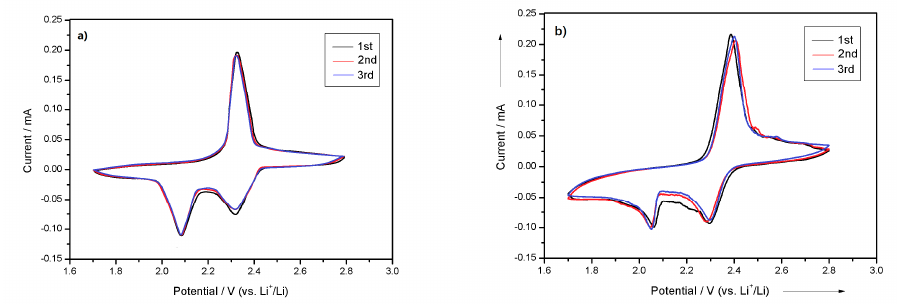
Figure 8. ( a ) The first cycle of cyclic voltammetry (CV) curves of poly(S-Sty-P) terpolymer @ CCB battery; ( b ) the first cycle of CV curves of poly(S-Sty-P) terpolymer @ GF battery.